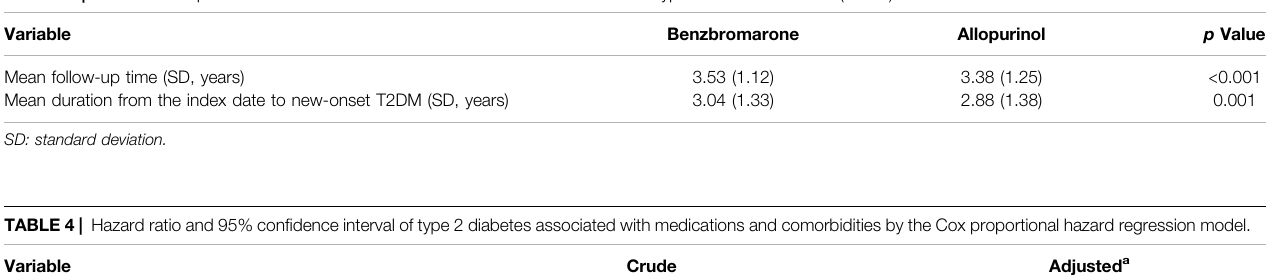
Thiazide diuretics use (non-use as a reference)